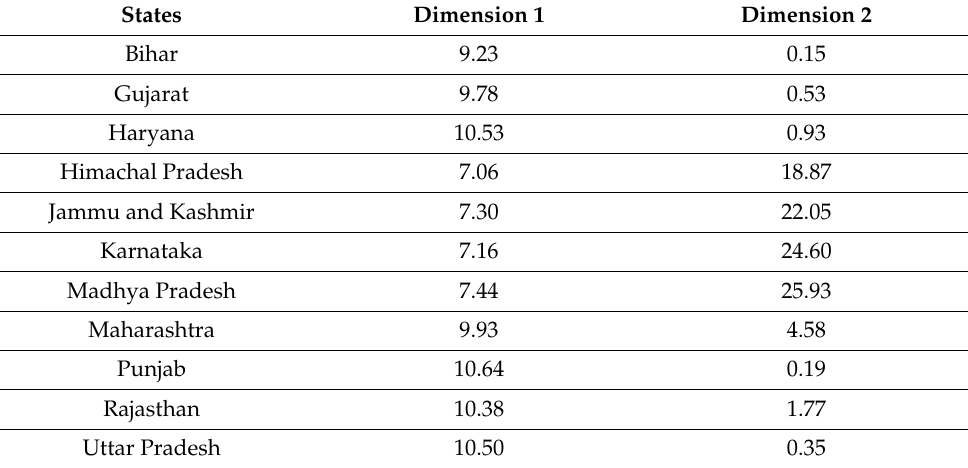
Table 3. Yield principal components.